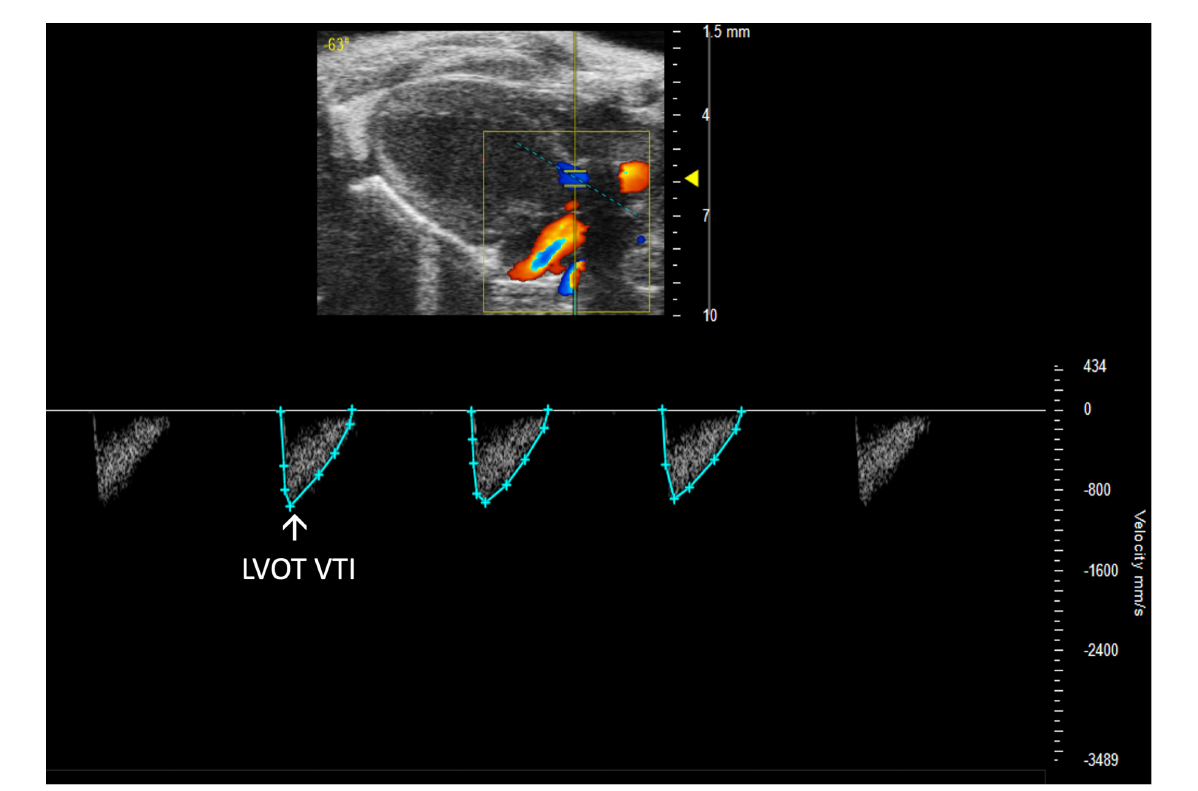
FIGURE10 Representative image displaying left ventricular outflow tract velocity time integral (LVOT VTI), a measure of blood flow out of the ascending aorta which is obtained by calculating the area under the curve in the PW Doppler mode of the parasternal long axis